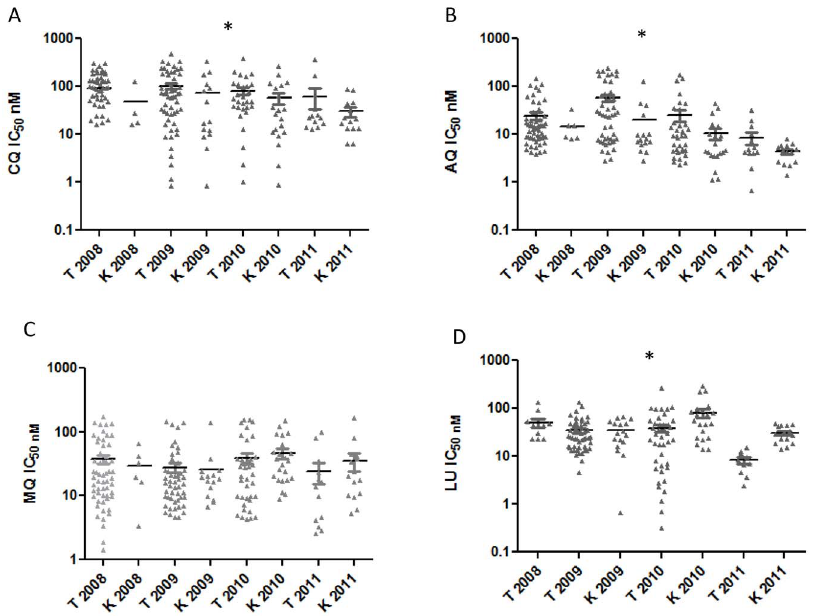
Figure 1. Pfcrt K76T SNP compared against drug IC 50 (in nM). A. Comparison of Pfcrt K76T SNP against CQ IC 50 stratified by year; B. Comparison of Pfcrt K76T SNP against AQ IC 50 stratified by year; C. Comparison of Pfcrt K76T SNP against MQ IC 50 stratified by year; D. Comparison of Pfcrt K76T SNP against LU IC 50 stratified by year. Median values are shown. *indicates data is significant.